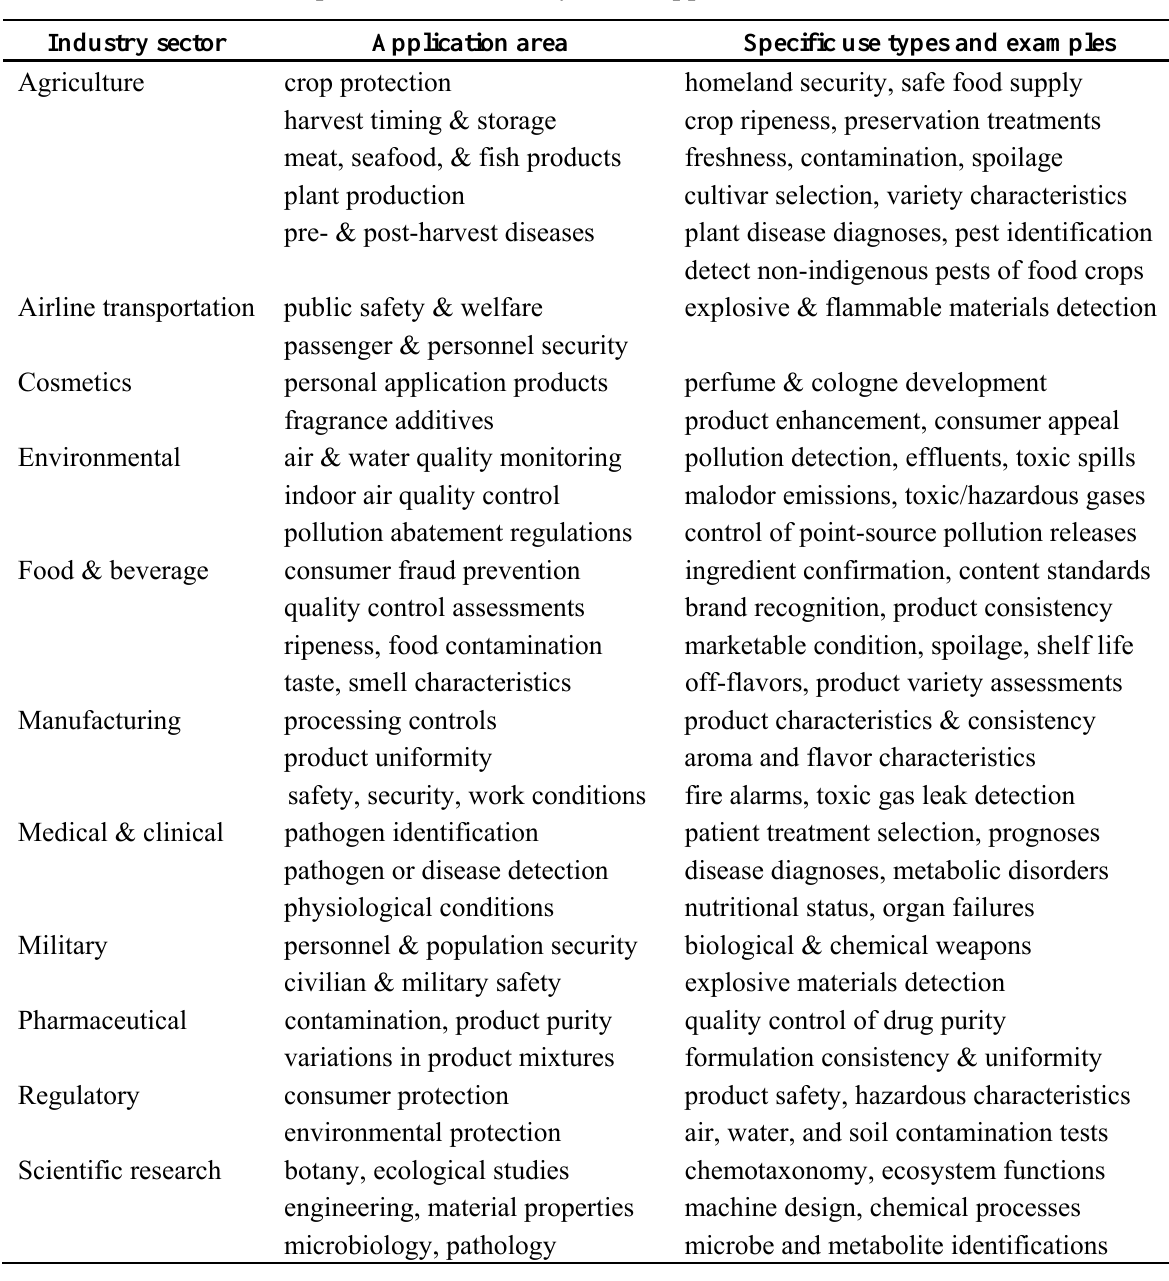
Table 7 . Examples of some industry-based applications for electronic